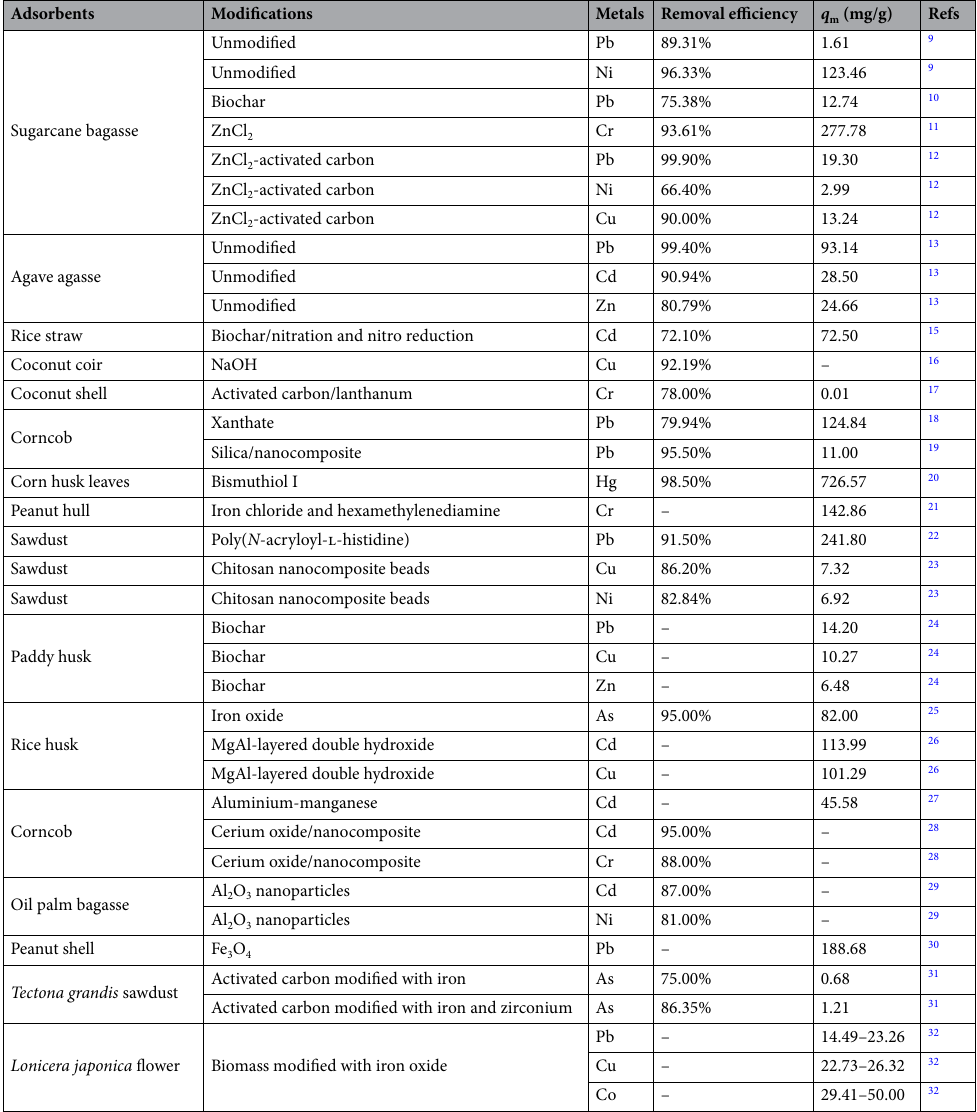
Table 1. The elimination of heavy metals from wastewater from various agriculture